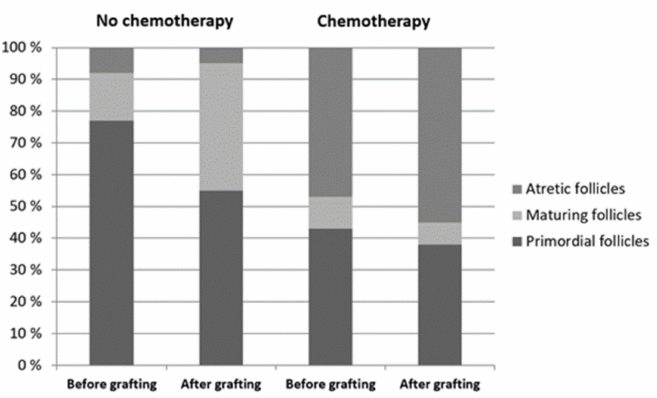
Figure 2. Proportions of primordial, maturing, and atretic ovarian follicles before and after 22 weeks of xenotransplantation in ovarian cortex with and without chemotherapy